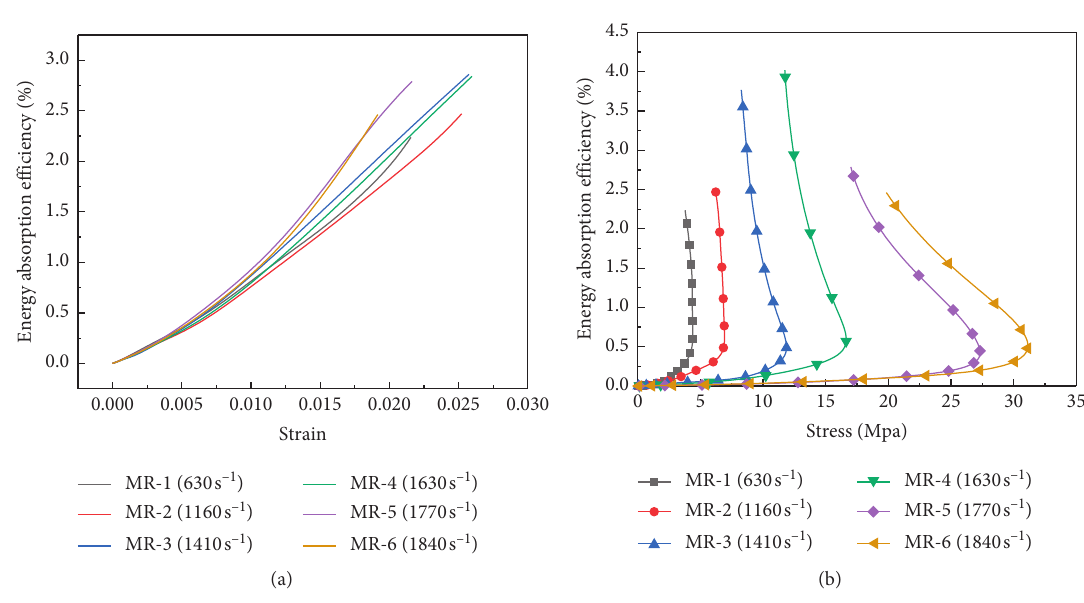
Figure 8: (a) E − ε curves; (b) E − σ